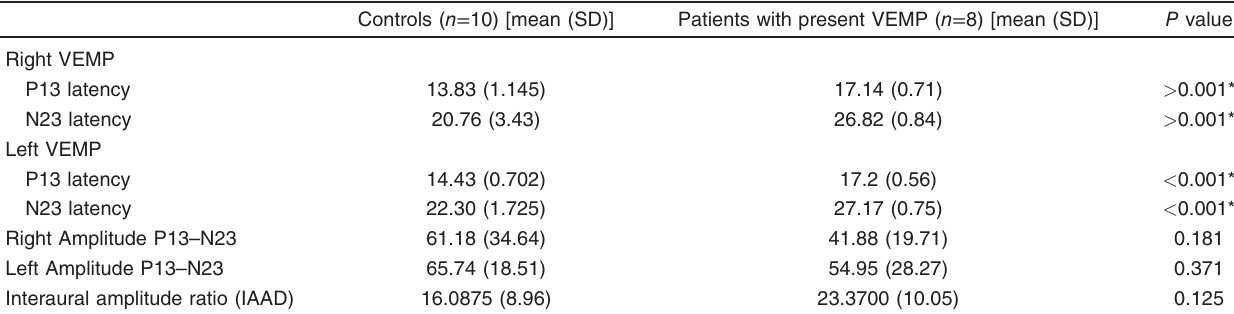
Table 4 Comparison between patients with present vestibular-evoked myogenic potential and controls in mean value of vestibular-evoked myogenic potential parameters Controls ( n = 10) [mean (SD)] Patients with present VEMP ( n = 8) [mean (SD)]